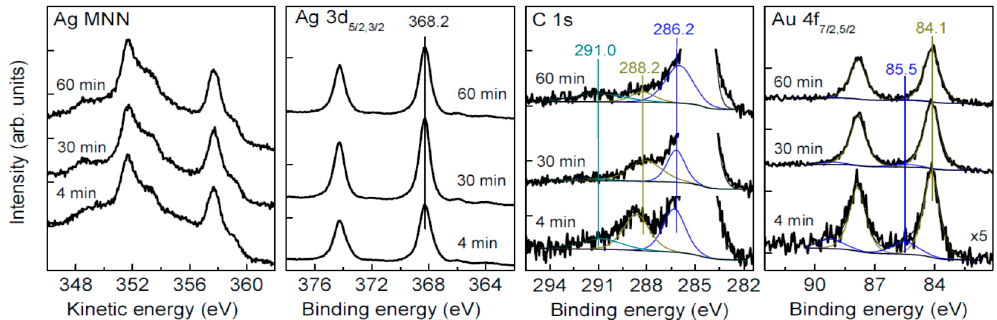
Figure 5. X-ray photoelectron spectra from silver films conditioned in 0.2 mM HAuCl 4 aqueous solution for 4, 30, and 60 min.